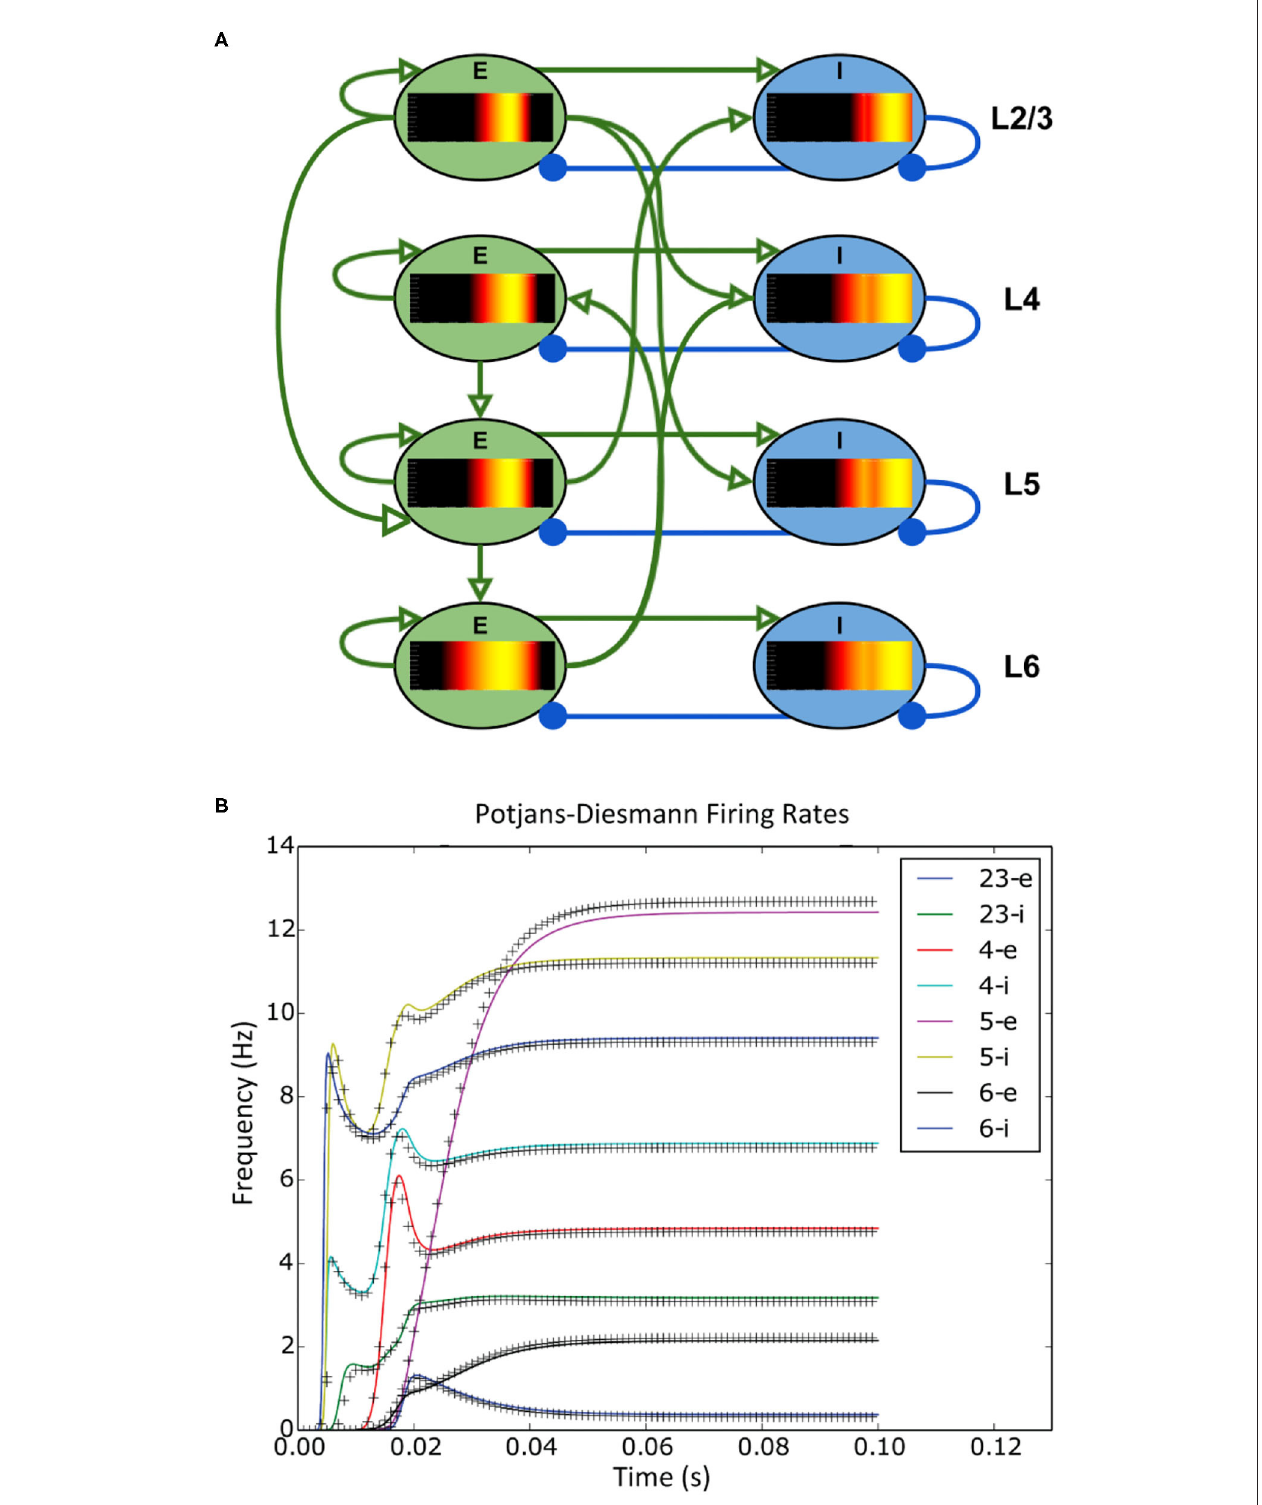
FIGURE 5 | (A) A representation of the connectivity between populations in the Potjans-Diesmann microcircuit model. Each population shows the probability density at an early point in the simulation before all populations have reached a steady state. All populations are of leaky-integrate-and-fire neurons and so the density plots show membrane potential in the horizontal axis. The vertical axis has no meaning (probability mass values are the same at all points along the vertical). (B) The firing rate outputs from MIIND (crosses) in comparison to those from DiPDE for the same model (solid lines).